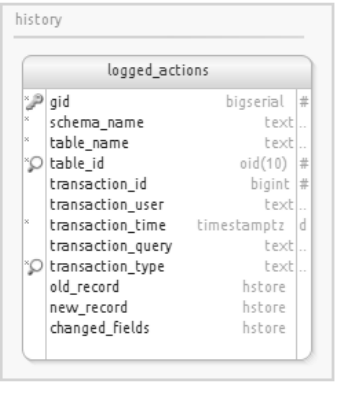
Figure 3. History schema. Figure 3. History